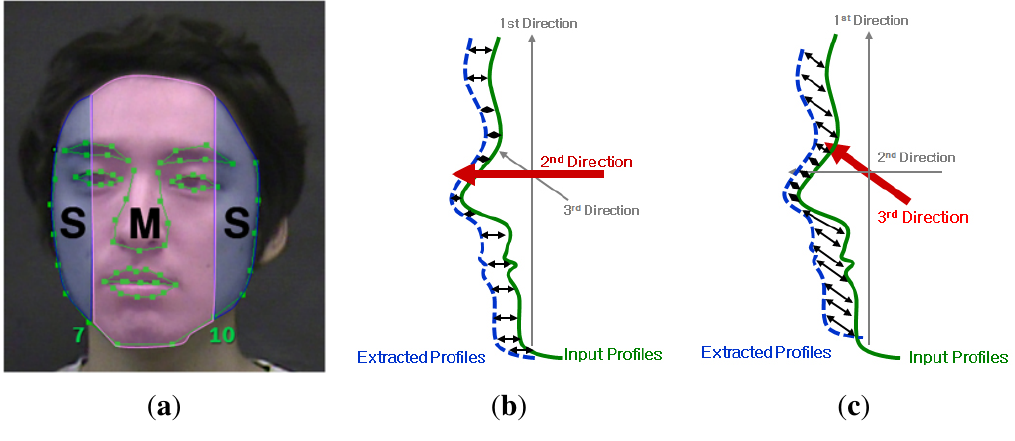
Figure 14. Direction for extracting the corresponding gallery profile and distance difference measurement according to the partition face region. ( a ) Division of middle and side regions of the face; ( b ) extraction and measurement direction for the middle region of the face; and ( c ) extraction and measurement direction for the side region of the